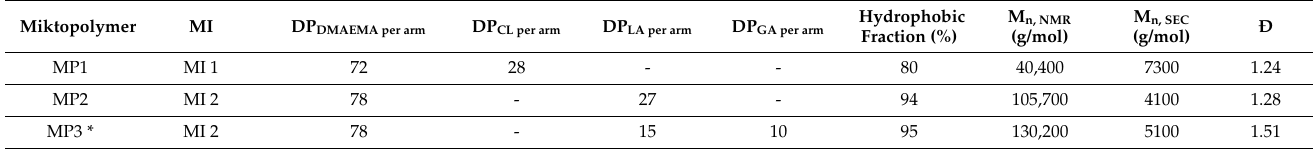
Figure 1. The synthesis of macroinitiators ( A ) and miktopolymers ( B ). Table 2. Characterization of obtained